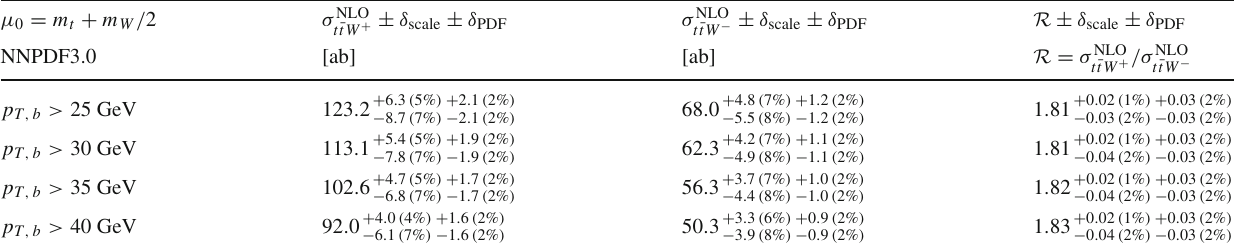
Table 1 NLO QCD integrated fiducial cross sections for pp → t ¯ tW ± estimated from the scale variation and from the PDFs are listed as well. √ s = 13 TeV. Also in the multi-lepton final state at the LHC with Four different values of the p T , b cut are used. The NNPDF3.0 PDF set /σ NLO shown are results for R = σ NLO is employed and μ R = μ F = μ 0 where μ 0 = m t + m W / 2 . Theoretical uncertainties as t ¯ tW + t ¯ tW −